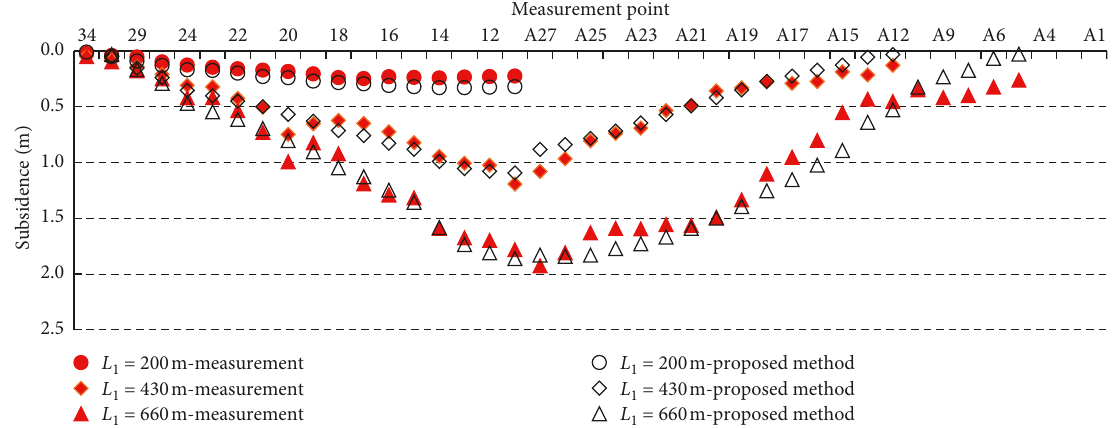
Figure 9: Comparison between predicted results obtained by the proposed method and measured results at the measurement points of surface subsidence.